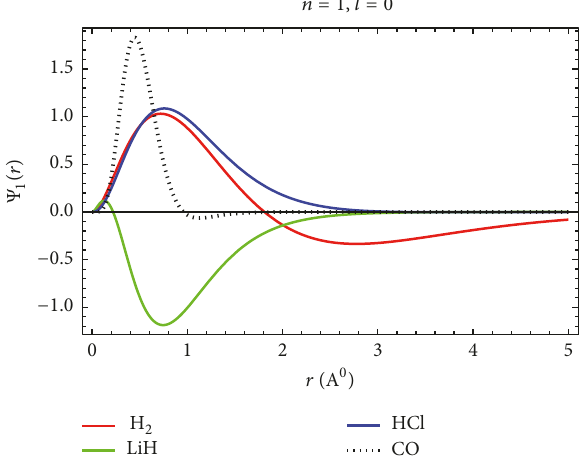
Figure 3: Wave function plot for the interaction potential with orbital angular quantum number 𝑙 = 0 .